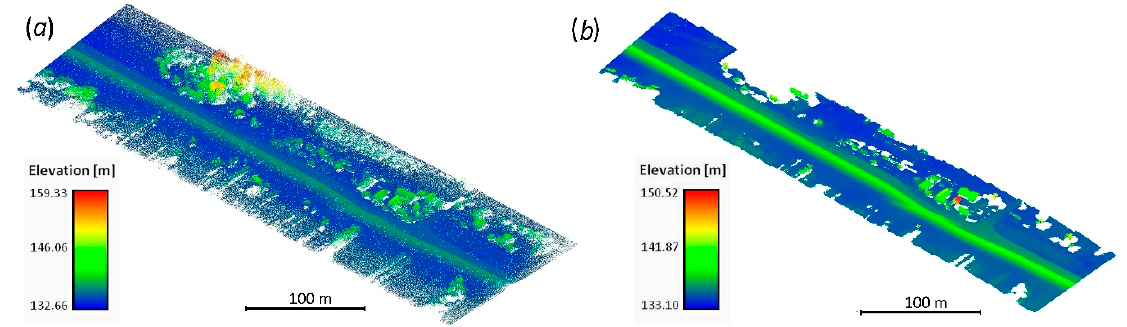
Figure 4. Isometric view of color-coded elevation of a point cloud for the Annopol test area: ( a ) ULS-based—YellowScan Surveyor, ( b ) photogrammetric-based from Agisoft Photoscan.